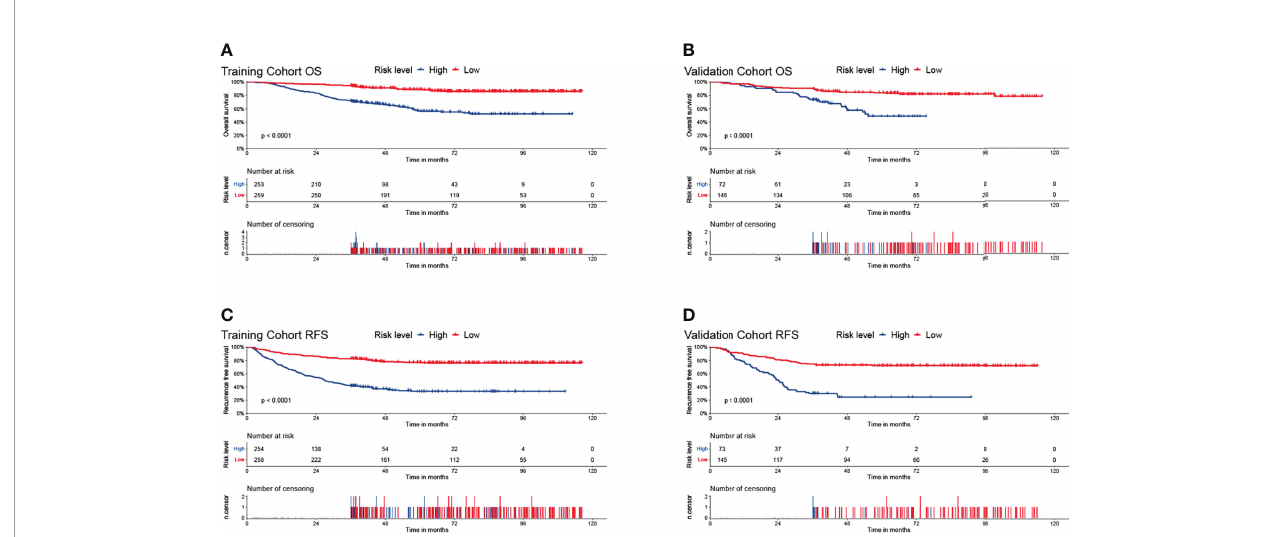
FIGURE 5 | The Kaplan – Meier survival curves for low- and high- risk groups in patients with HCC based on risk scores. The overall survival Kaplan – Meier survival curves in the training cohort (A) and the validation cohort (B) . The recurrence-free survival Kaplan – Meier survival curves in the training cohort (C) and the validation cohort (D)